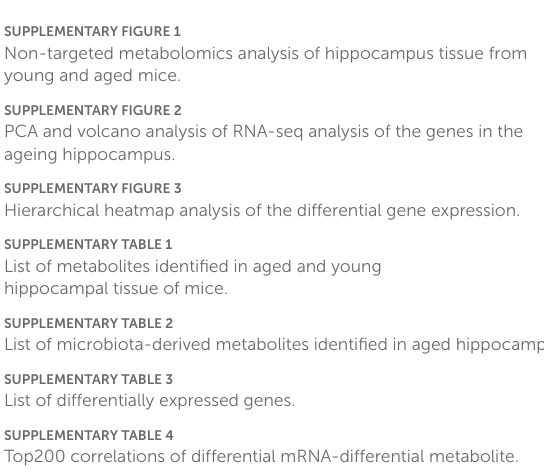
SUPPLEMENTARYTABLE3 List of differentially expressed genes. SUPPLEMENTARYTABLE4 Top200 correlations of differential mRNA-differential